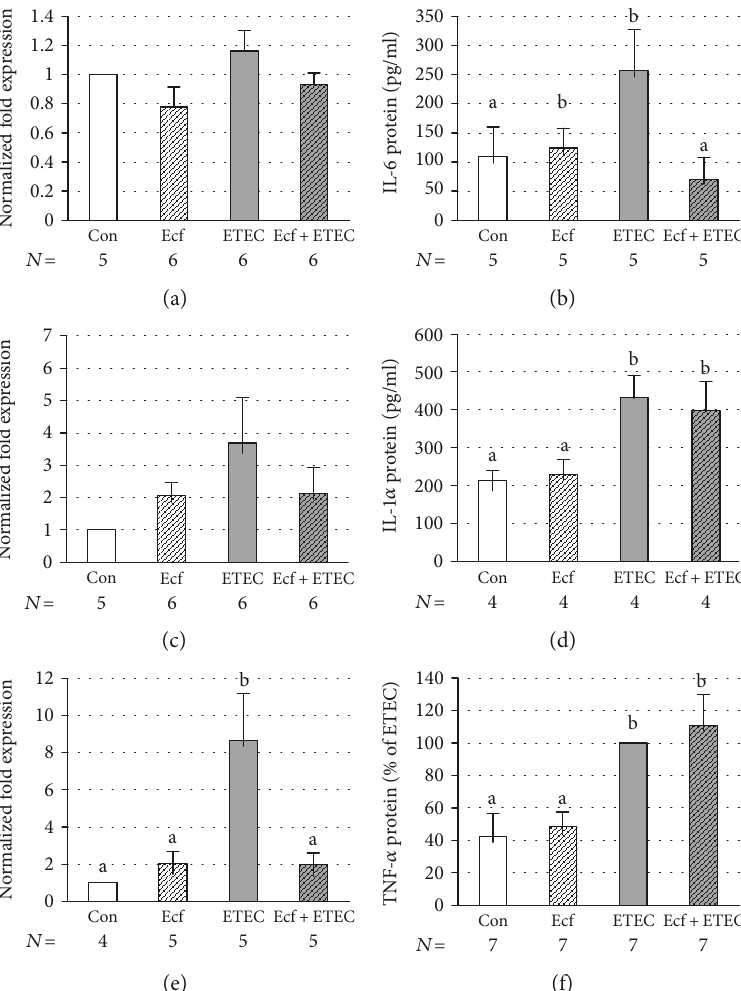
Figure 7: mRNA expression of IL-6 (a), IL-1 α (c), and TNF- α (e) and cytokine release of IL-6 (b), IL-1 α (d), and TNF- α (f) from IPEC-J2 cells after treatment with bacterial strains (Ecf, ETEC, and Ecf + ETEC) or without bacteria (Con = control) [means ± SEM]. Samples were taken after 4h (mRNA) or 8h (protein release). Groups di ff er signi fi cantly ( P ≤ 0 05 ) when marked with di ff erent letters, (e.g., a, b) in the fi gure. N =number of independent experiments as indicated in the fi gure